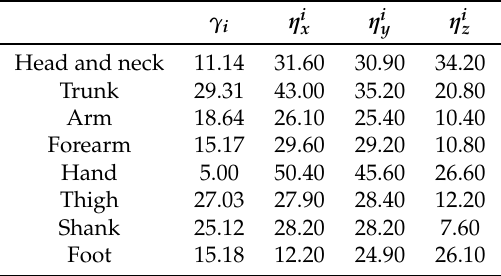
Table A4. Reynolds-NASA model parameters for each body segment (length and gyration radii). γ i η i x